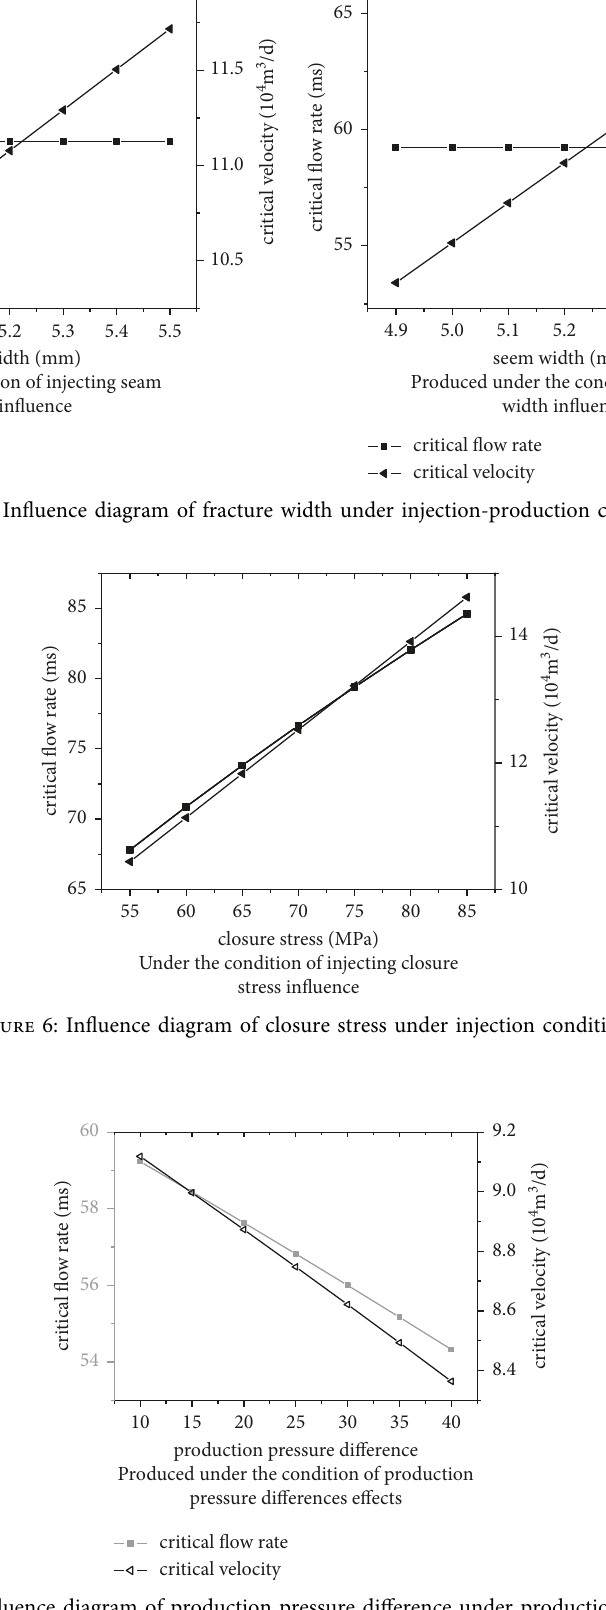
Figure 7: Influence diagram of production pressure difference under production